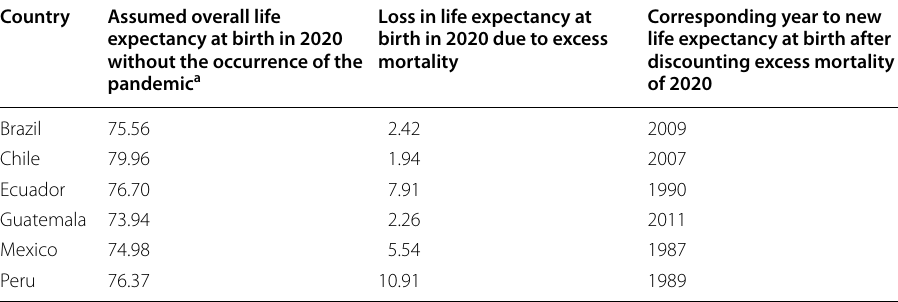
Table 2 Estimated loss in life expectancy in 2020 due to excess mortality in selected Latin American